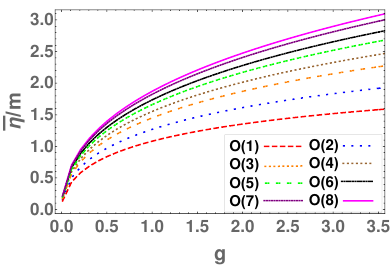
Figure 2 . The optimized variational mass, in units of m , as a function of g obtained by resumming M (odd orders) and M 2 (even